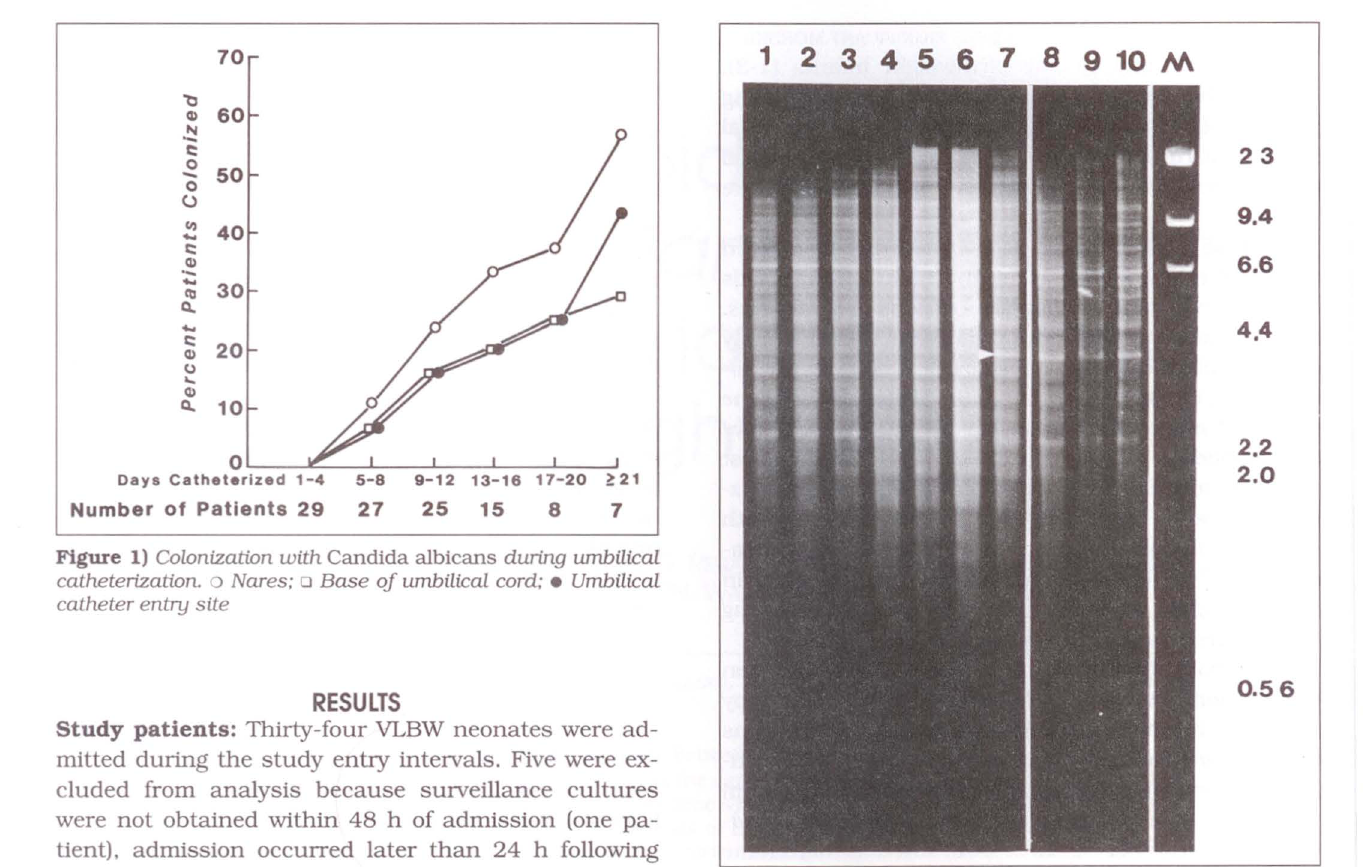
Figure 2) EcoR1 digests of DNA .from Candida albicans ana· lyzed by agarose gel eLectrophoresis. Size markers are indicated on the right (kilobase pairs). Lanes 1 to 7 contain DNA .from patient 2. Six of these samples show the same pattern (desig nated pattern B) with predominant bands at 6.5, 3.8 and 2. 6 kb. but the sampLe in lane 7 has an extra band at 4.2 kb